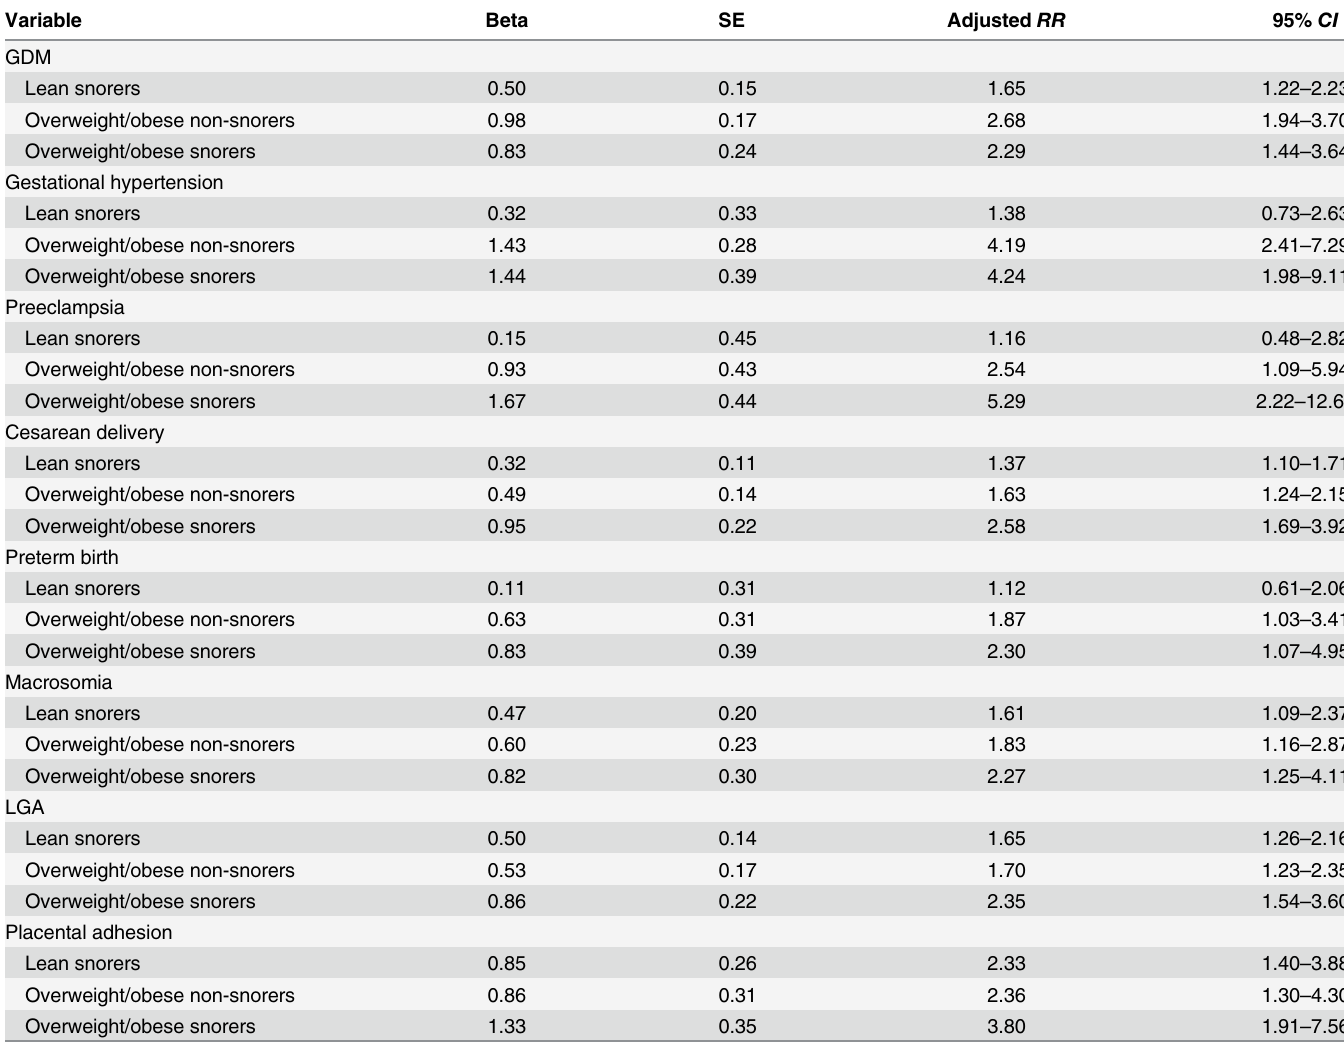
Table 4. Adjusted RR and 95% CI of pregnancy outcomes by pre-pregnancy BMI and snoring